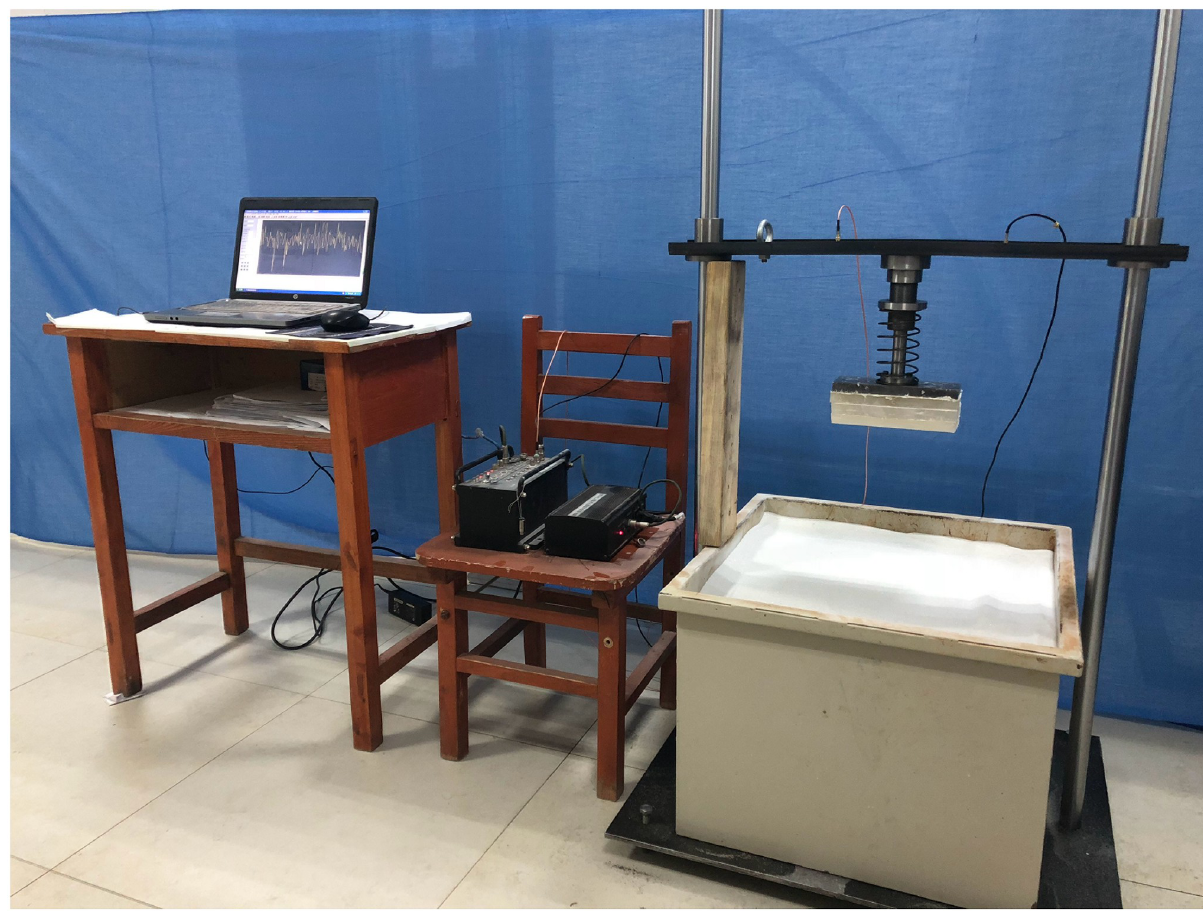
Fig 3. Impact test devices. Impact test bench, sand box, and a data acquisition and control system.